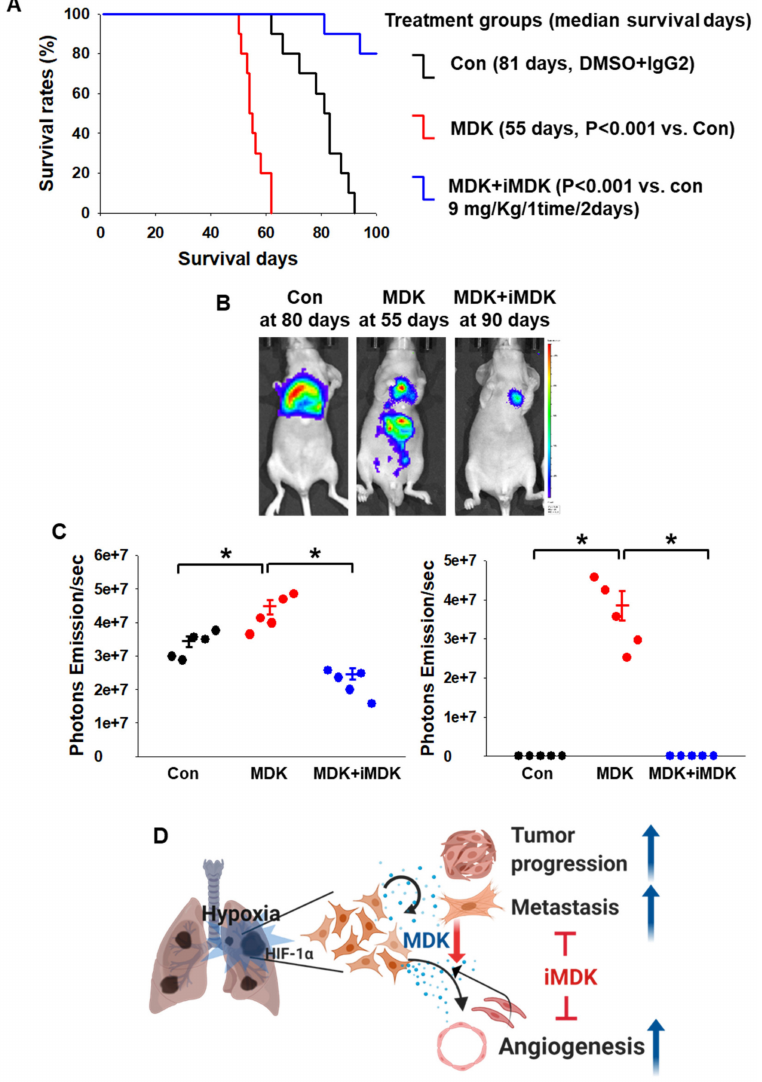
Figure 7. Increased life span and tumor reduction in iMDK-treated lung tumorigenesis. ( A ) Kaplan–Meier survival curves in lung orthotopic tumor-bearing mice treated continuously with control, MDK, and MDK + iMDK starting at 30 days after treatment. DMSO treated mice showed a median survival days of 81 days; mice receiving continuous MDK + iMDK treatment demonstrated a survival benefit but not in the MDK-expression group. Kaplan–Meier statistic, n = 5, * p < 0.001. ( B ) Representative bio-luminescence images at 80 days for the control, at 55 days for MDK, and at 90 days for iMDK are shown, revealing a BLI signal originating from the site of injection. ( C ) The photon emission values in Figure 7B represent the mean ± SEM of the indicated number of mice. * p < 0.05 based on Student’s t -test. ( D ) Schematic diagram summarizing hypoxia-induced MDK NSCLC cell tumor progression and metastasis and its